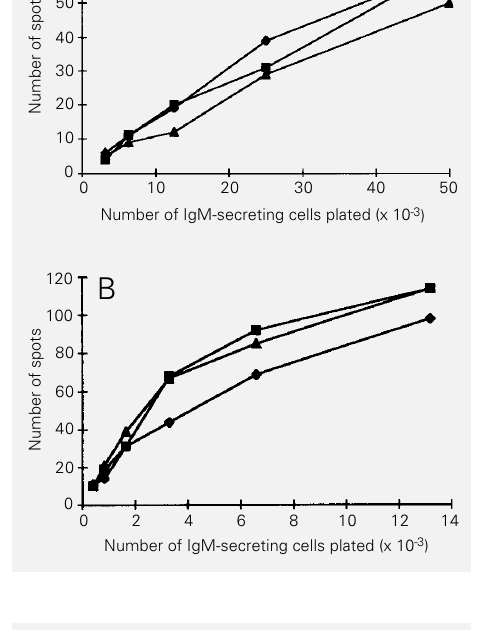
Figure 3 - Frequency of cells se- creting IgM antibodies reactive with self components among IgM-secreting spleen cells ob- tained from mice immunized with lung extract plus CFA (A) or CFA alone (B). ¢ , Gut; (cid:224) , lung.